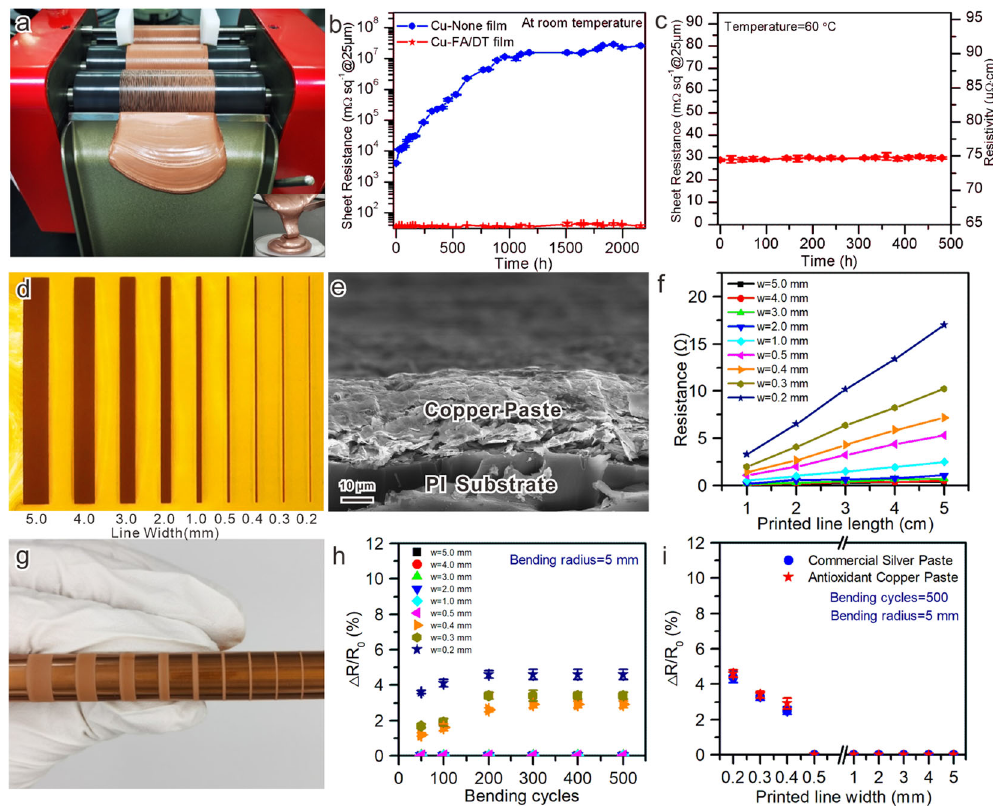
Fig. 3 Electrical and mechanical properties of the antioxidant copper paste. a Optical images of the copper paste prepared by a three-roll grinder. b Long-time stability of copper fi lms at room temperature. c Long-time stability of the Cu-FA/DT fi lm at 60 °C. d Optical image of lines screen-printed on PI substrate with different widths. e Cross-sectional SEM image of the printed line with 1.0 mm width. f Electrical resistance of the printed conductive lines as a function of line widths. g Bending test on a cylindrical rod with a radius of 5 mm. h Relative electrical resistance of the printed conductive lines on PI during 500 bending cycles at a bending radius of 5 mm. i Relative electrical resistance of various conductive lines on PI printed by different conductive pastes after 500 bending